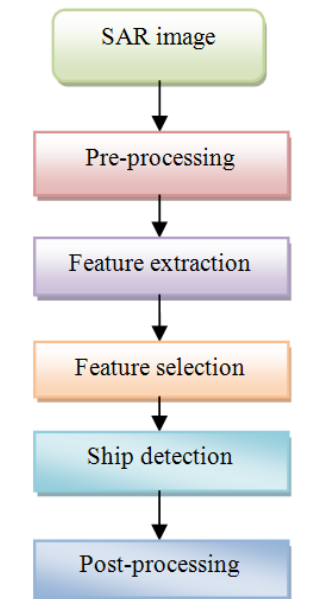
Figure 1. Flowchart of the proposed algorithm